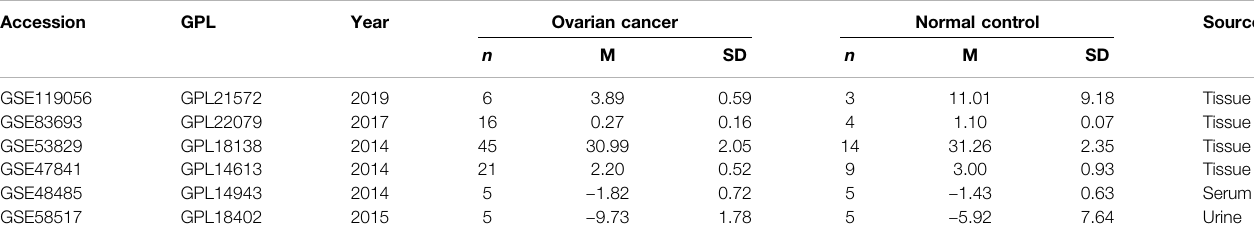
TABLE 1 | Gene Expression Omnibus datasets